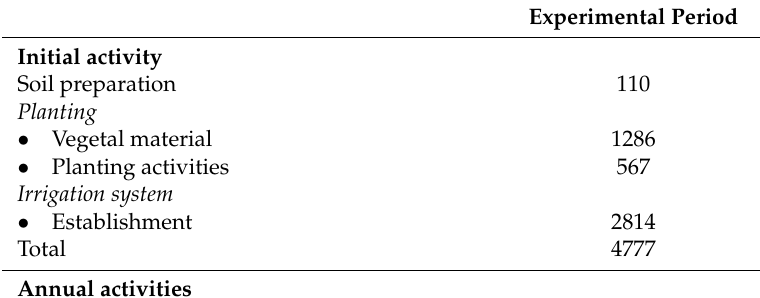
Table 6. Costs ( € ) per ha for the cultivation of the species selected in the